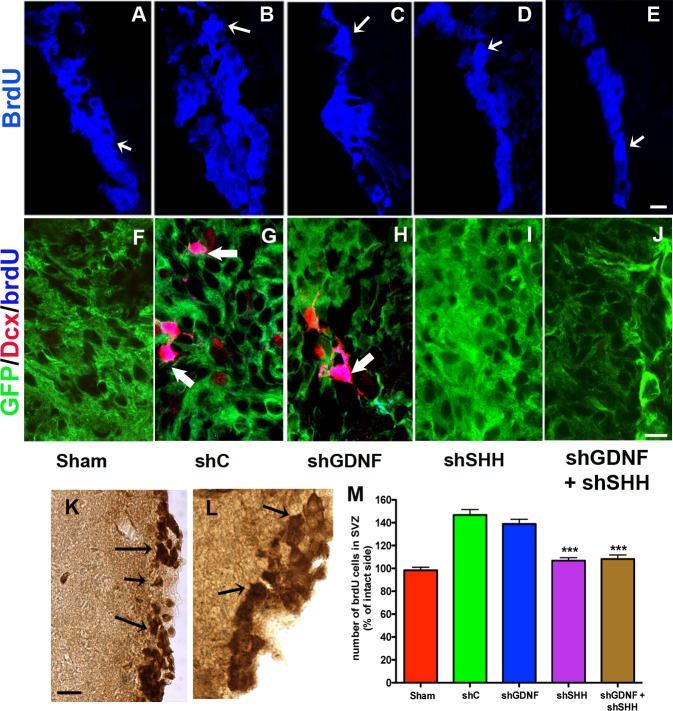
SHH silencing reduces grafted NPC-mediated endogenous neurogenesis.Effects of SHH and GDNF silencing on grafted NPC-induced endogenous neurogenesis and neuroblast migration were examined. As shown in A-E, in comparison to animals with control NPC implants, those transplanted with SHH and GDNF+SHH silenced NPCs showed reduced brdU labeling within the host forebrain SVZ niche. In support of these data, cell counts indicated lower numbers of brdU+ cells in the ipsilateral SVZ of rats that had received SHH or GDNF+SHH silenced NPC transplants (arrows, examples of DAB labeled cells counted in K, L, stereological counts in M). Further, migrating brdU+/dcx+ neuroblasts, which were observed in the striatal parenchyma, particularly in regions neighboring grafts, in control NPC receiving animals (arrows, G), were missing in those with SHH or GDNF+SHH silenced cells (I, J). With regard to animals harboring GDNF silenced cells, a significant reduction in brdU+ cells (M) or an absence of brdU+/dcx+ cells in the lesioned and grafted striatum (H) was not observed. Values are expressed as mean ± SEM [***p<0.001 compared to shC, one way ANOVA with Bonferroni’s post-hoc test]. Scale bars: A-E—50 μm, F-J—10 μm, K, L—50 μm.